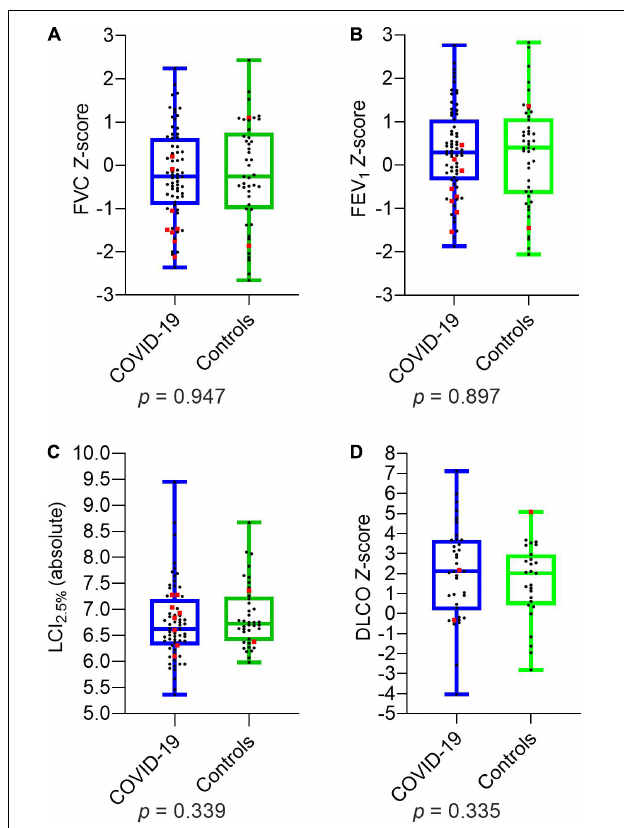
FIGURE 1 | Depiction of pulmonary function parameters for COVID-19 and controls: (A) FVC Z -score (B) FEV 1 Z -score (C) LCI 2 . 5% (absolute) (D) DLCO Z -score. Boxplots show medians, quartiles, minimum and maximum values. The dots represent the individual values of participants. Participants with severe infection within the last 6 months are marked as red squares. Differences were considered statistically significant at p ≤ 0.05. LCI 2 . 5% , Lung Clearance Index at 2.5% of starting concentration; FVC, Forced Vital Capacity; FEV 1 , Forced Expiratory Volume in the first Second; DLCO, Diffusion Capacity of the lungs for Carbon